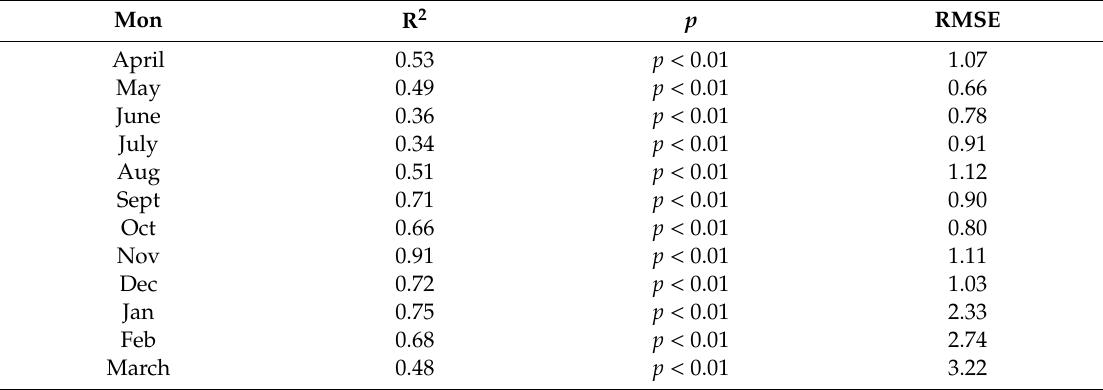
Table 1. The relationship between PRI and LUE from April 2014 to March 2015 for each month.